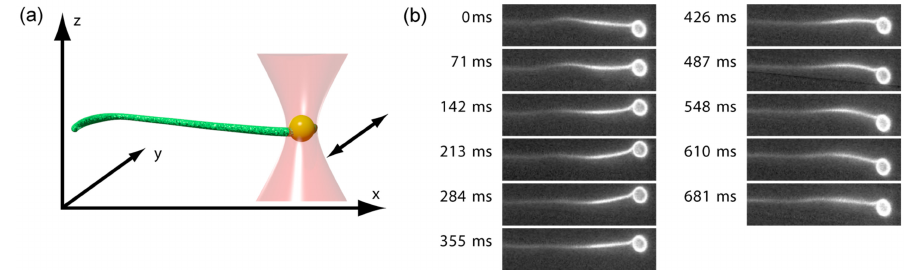
Figure 1. ( a ) A 2- µ m polystyrene bead coated with streptavidin is attached to an actin bundle enriched with biotinylated actin monomers. This bead is trapped by optical tweezers, and an oscillatory movement of the trap in the xy -plane induces oscillations in the bundle. The oscillation amplitudes subsequently decay when traveling through the bundle, a process which can be captured by fluorescence microscopy; ( b ) Fluorescence images of the experimental procedure. The 11 images represent half a period at a frequency of 0.7